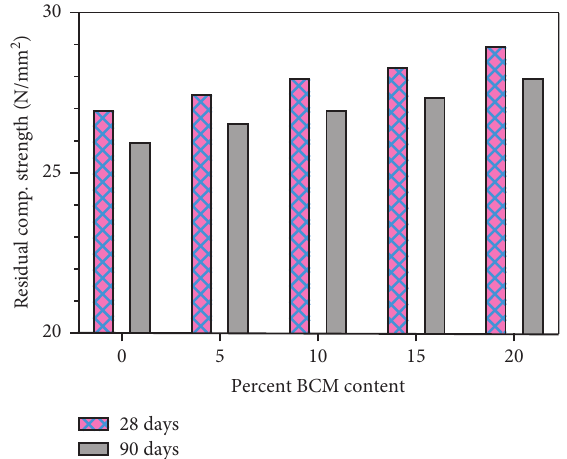
Figure 7: Residual compressive strength of samples exposed to chloride